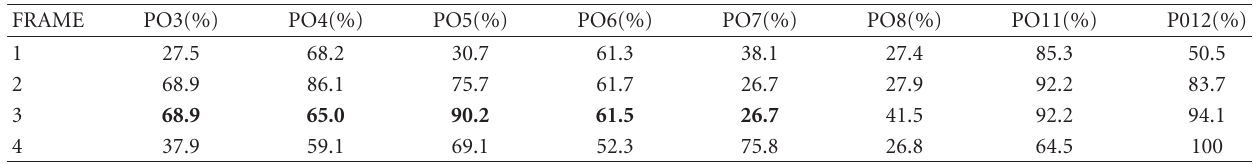
Table 6: The % FLPE crisp values of the four frames for Figure 11.